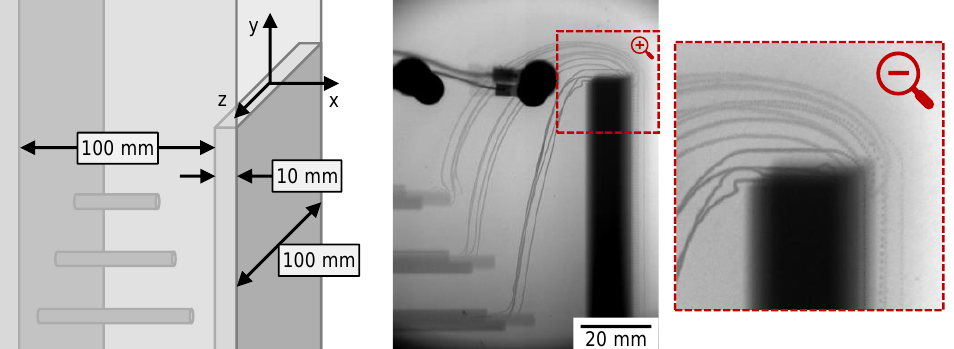
Figure 7. Tracking of tracer particles carried by the overflowing foam in different measuring planes z of the three-dimensional configuration: using small tubes, three tracer particles were added into the foam flow at different but fixed starting positions ( x 0 , y 0 , z 0 ) in each measurement run in order to distinguish them from each other. The X-ray image, here a minimum intensity projection over time, visualises the motions paths of the three tracer particles during one measurement run. The focus was on the horizontal weir of the foam flow channel. As indicated in the three-dimensional sketch, the side walls at z = ± 50mm were transparent for both visible light and X-rays to a large